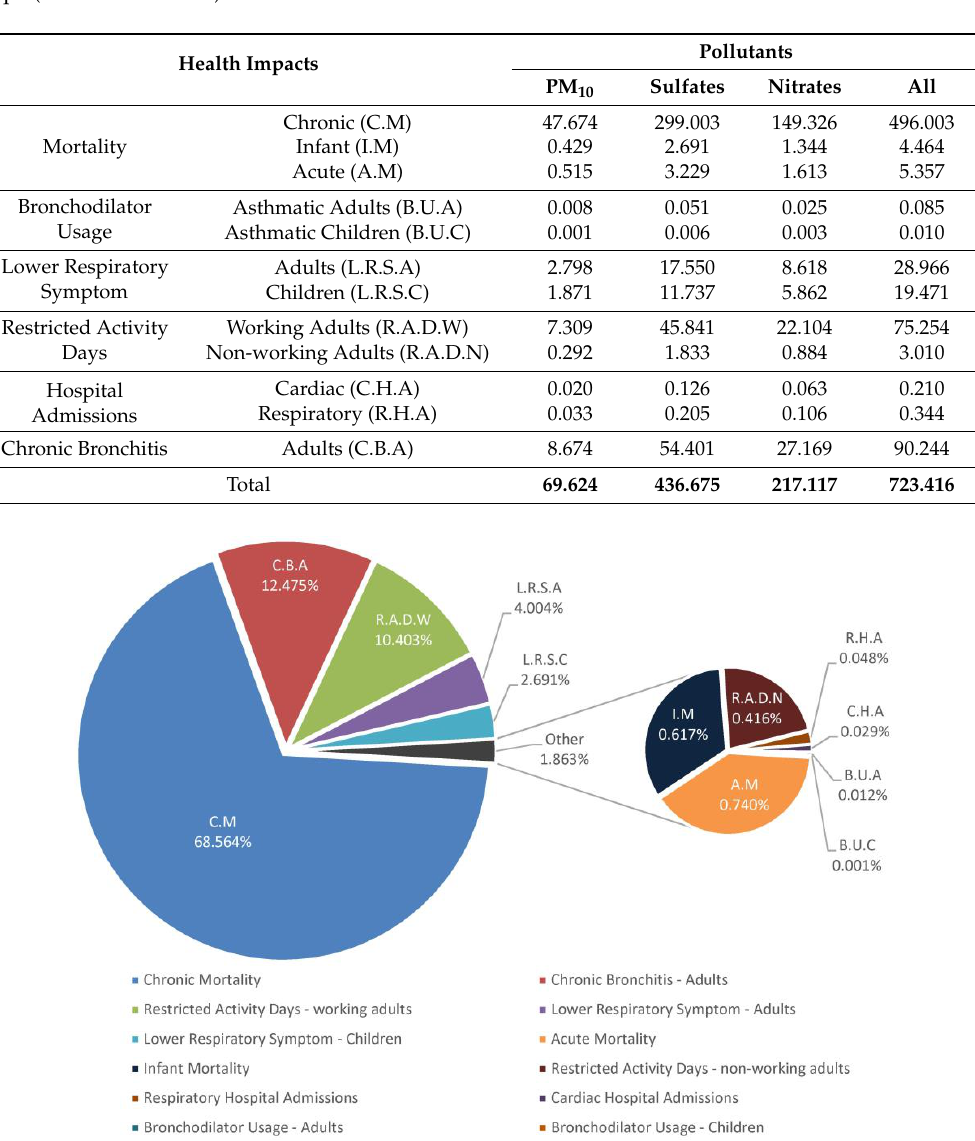
Table 3. Human health damage costs from the 61 power plants of Iran by health impact and pollutant type (million USD 2000).